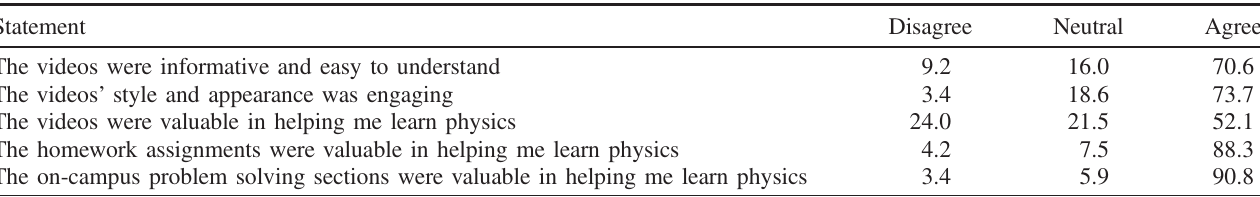
TABLE IV. Percentage of students who agree or disagree with statements in the end-of-course survey regarding various